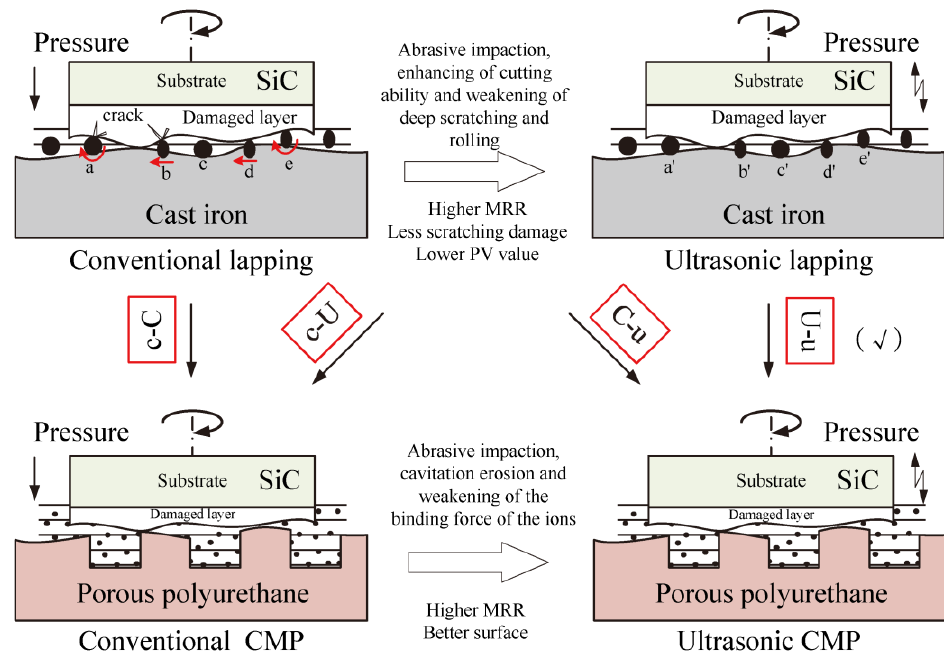
Figure 8. The material removal mechanism of CMP and lapping for SiC and its varied action under ultrasonic. The abrasive action in conventional lapping includes brittle three-body abrasion ( a ), brittle two-body abrasion ( b ), no contact ( c ), ductile two-body abrasion ( d ), and ductile three-body abrasion ( e ).